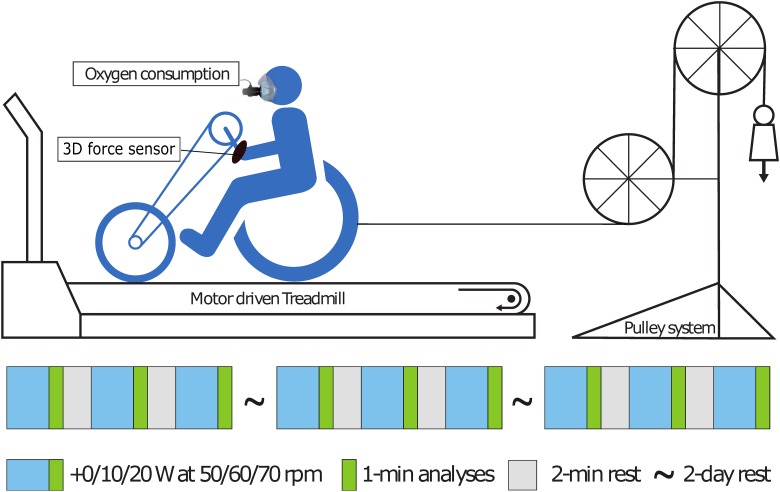
Overview of the protocol and the experimental set-up.The participants rode on a motorized treadmill (slope 0°) at a velocity of 1.94 m/s, while the oxygen consumption and heart rate were continuously measured. To impose extra resistance, a pulley system was attached to the back of the handcycle, to add 10 W and 20 W, respectively.